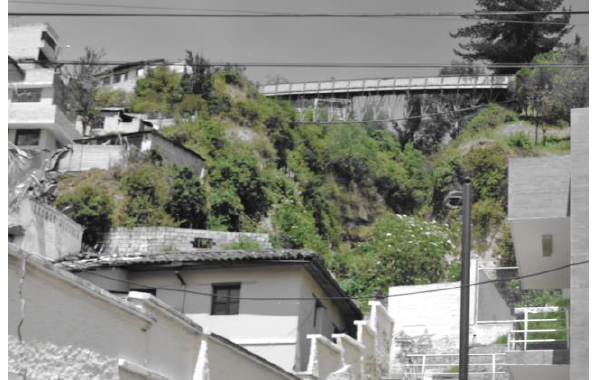
Figure 8. Contemporary condition: constructions above the Itchimbía ravine. San Juan slope. Photo by Marianela